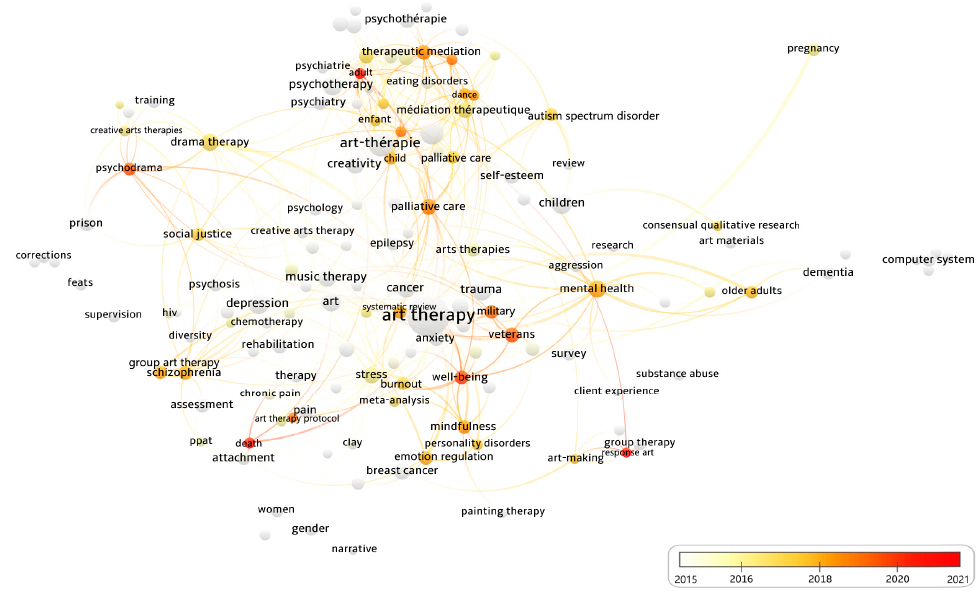
Figure 5. AT-aided health and well-being hotspots from 2015 to 2021 in the Overlay Visualization diagram generated by VOSviewer (devised by the authors).